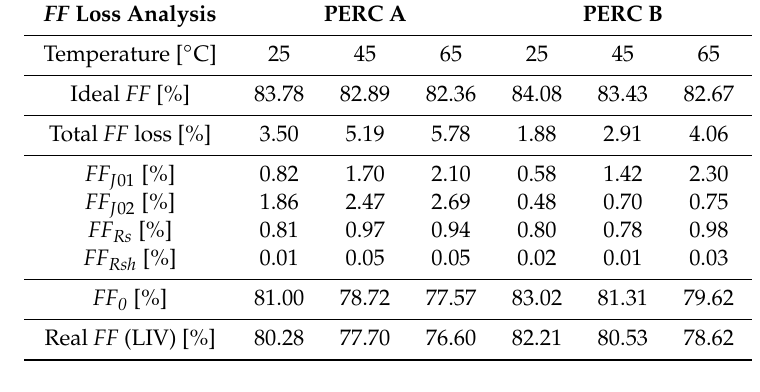
Table 2. Results of fill factor loss analysis of PERC A and PERC B according to temperature (the values are absolute).